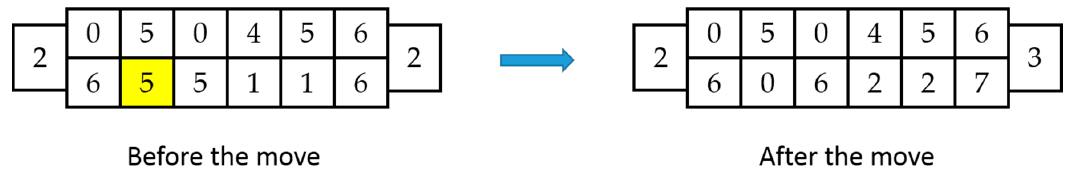
Figure 3. The initial board position of the game. Black numbers indicate the number of seeds inside a particular pit (kalaha), whereas red ones mean pit numbers (positions).